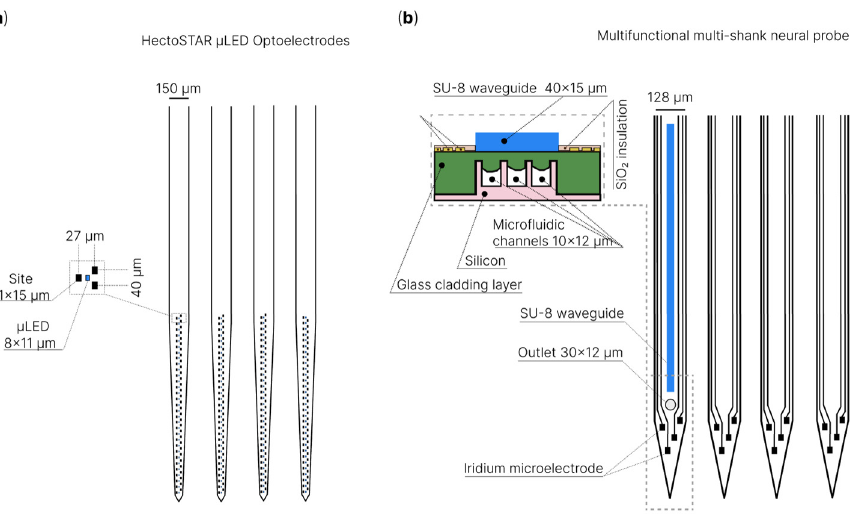
Figure 6. Schematic illustration of multifunctional systems that combine optical stimulation, micro- fluidic injections with electrophysiology: ( a ) HectoSTAR µLED optoelectrodes for in vivo optical crofluidic injections with electrophysiology: ( a ) HectoSTAR µ LED optoelectrodes for in vivo optical electrophysiology [272]; ( b ) multifunctional multi-shank neural probe [44,275]. electrophysiology [272]; ( b ) multifunctional multi-shank neural probe